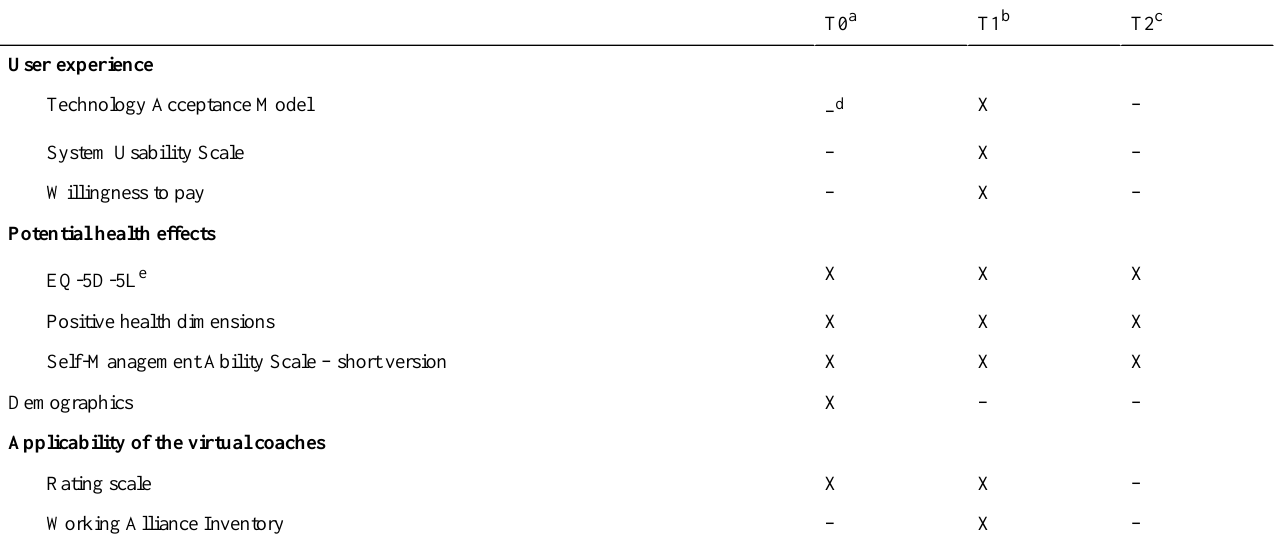
Table 1. Overview of the questionnaires and when they will be